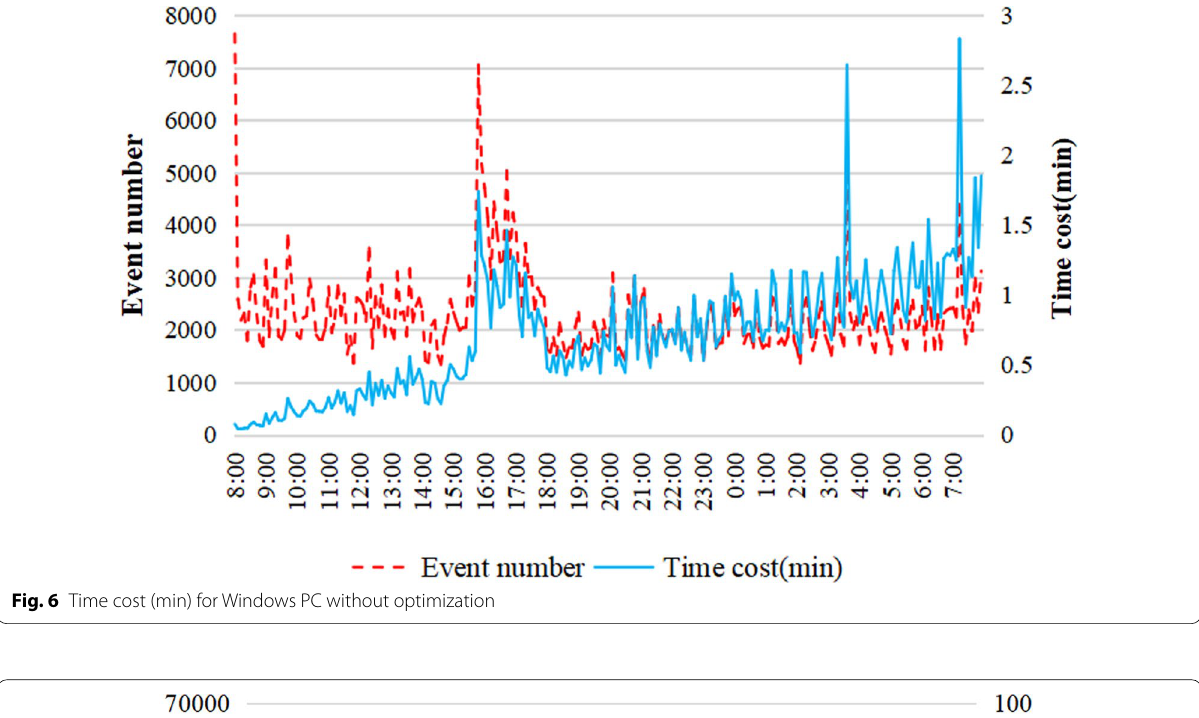
Fig. 6 Time cost (min) for Windows PC without optimization